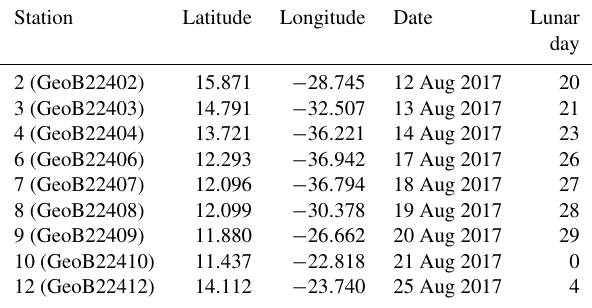
Table 1. Station number (in brackets their reference name in Kuˇcera et al., 2019), location (degree decimals), date of sampling and cor- responding day in the lunar cycle (LD). The studied sampling